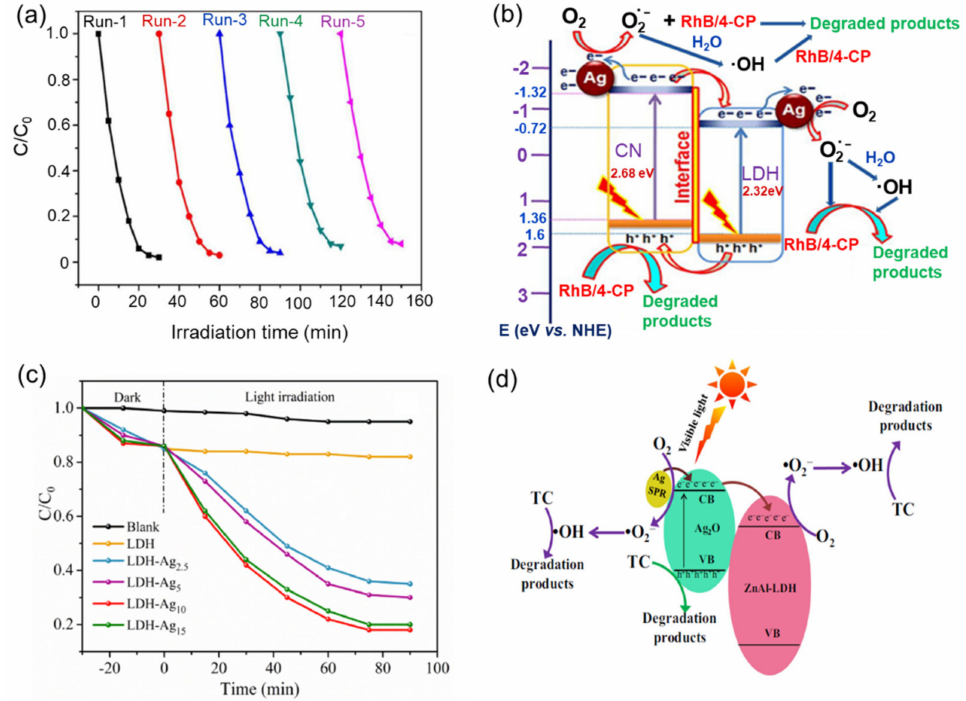
Figure 11. ( a ) Recycling results of Ag/CN/LDH-15 in photodegradation process of RhB, ( b ) graphical representation of the mechanism in photodegradation of RhB/4-CP by Ag/CN/LDH (Reprinted from [110] with permission of Elsevier, 2018), ( c ) Photocatalytic efficiency of pristine LDH and Ag/Ag 2 O/LDH in TC degradation and ( d ) Graphical representation of TC degradation via a potential photocatalytic process by Ag/Ag 2 O/LDH (Reprinted from [38] with permission of Elsevier,